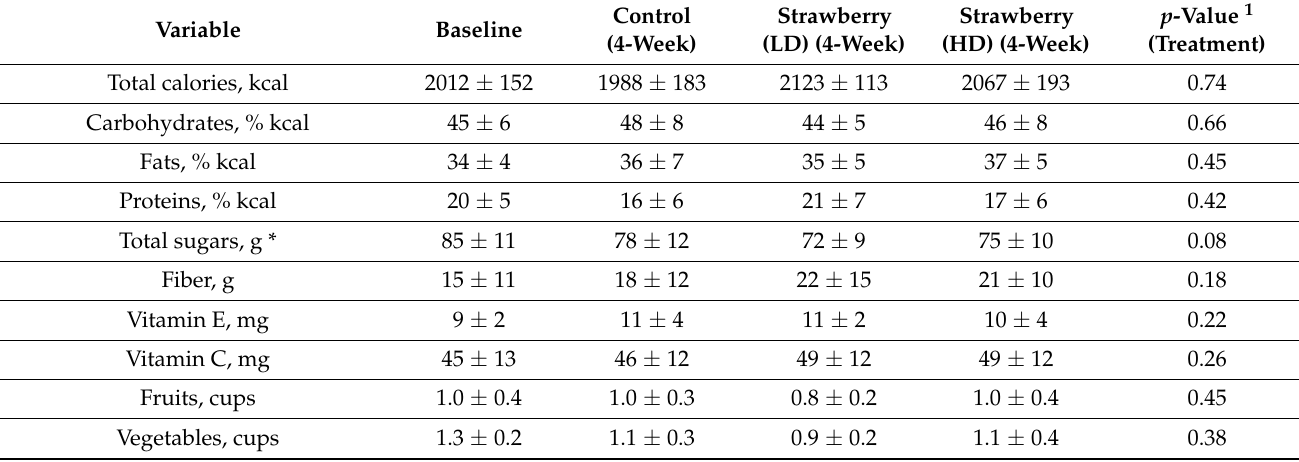
Table 6. Background daily dietary nutrient and food group intakes in obese adults with above optimal serum LDL cholesterol following each treatment period in a randomized crossover